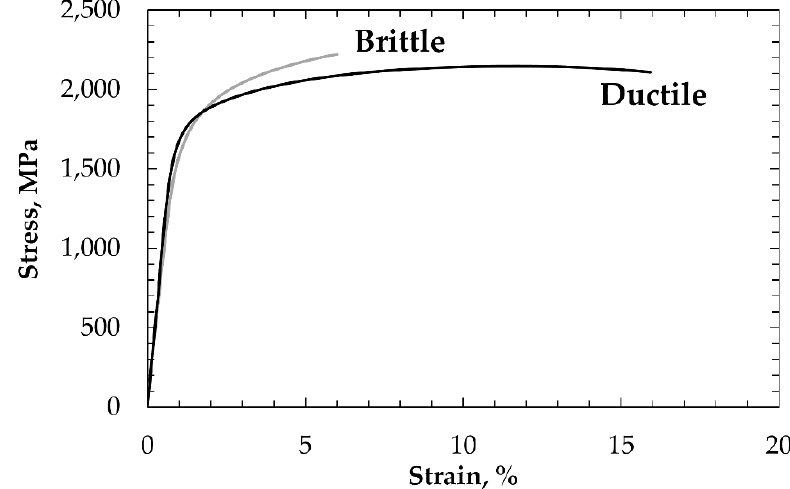
Figure 1. Example of the two different behaviours (brittle and ductile) identified on engineering stress–strain curves. Brittle behaviour may lead to higher maximum stress though the reproducibility is